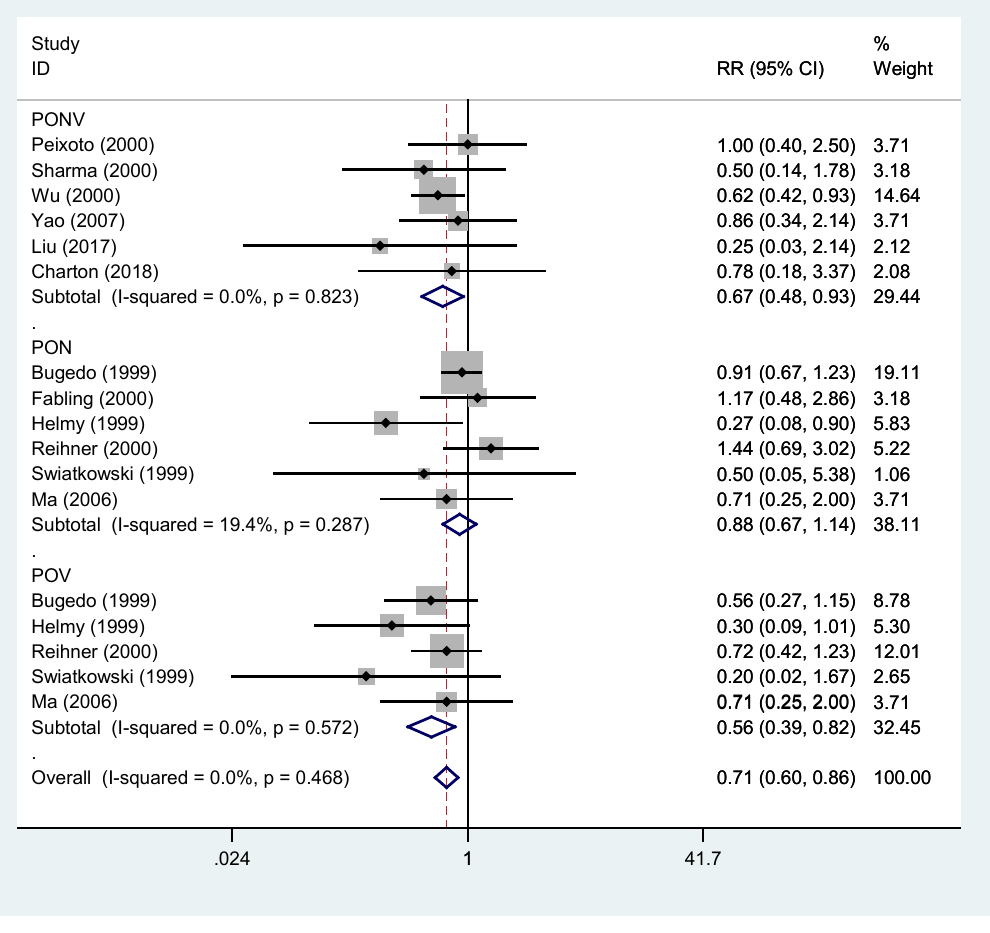
Figure 2: Forest plot of ondansetron vs droperidol for preventing PONV. The gray squares and horizontal lines indicate the RR and 95% CI, respectively. The area of the squares reflects the study specific weight (inverse of the variance). The blue diamond represents the pooled RR and 95%